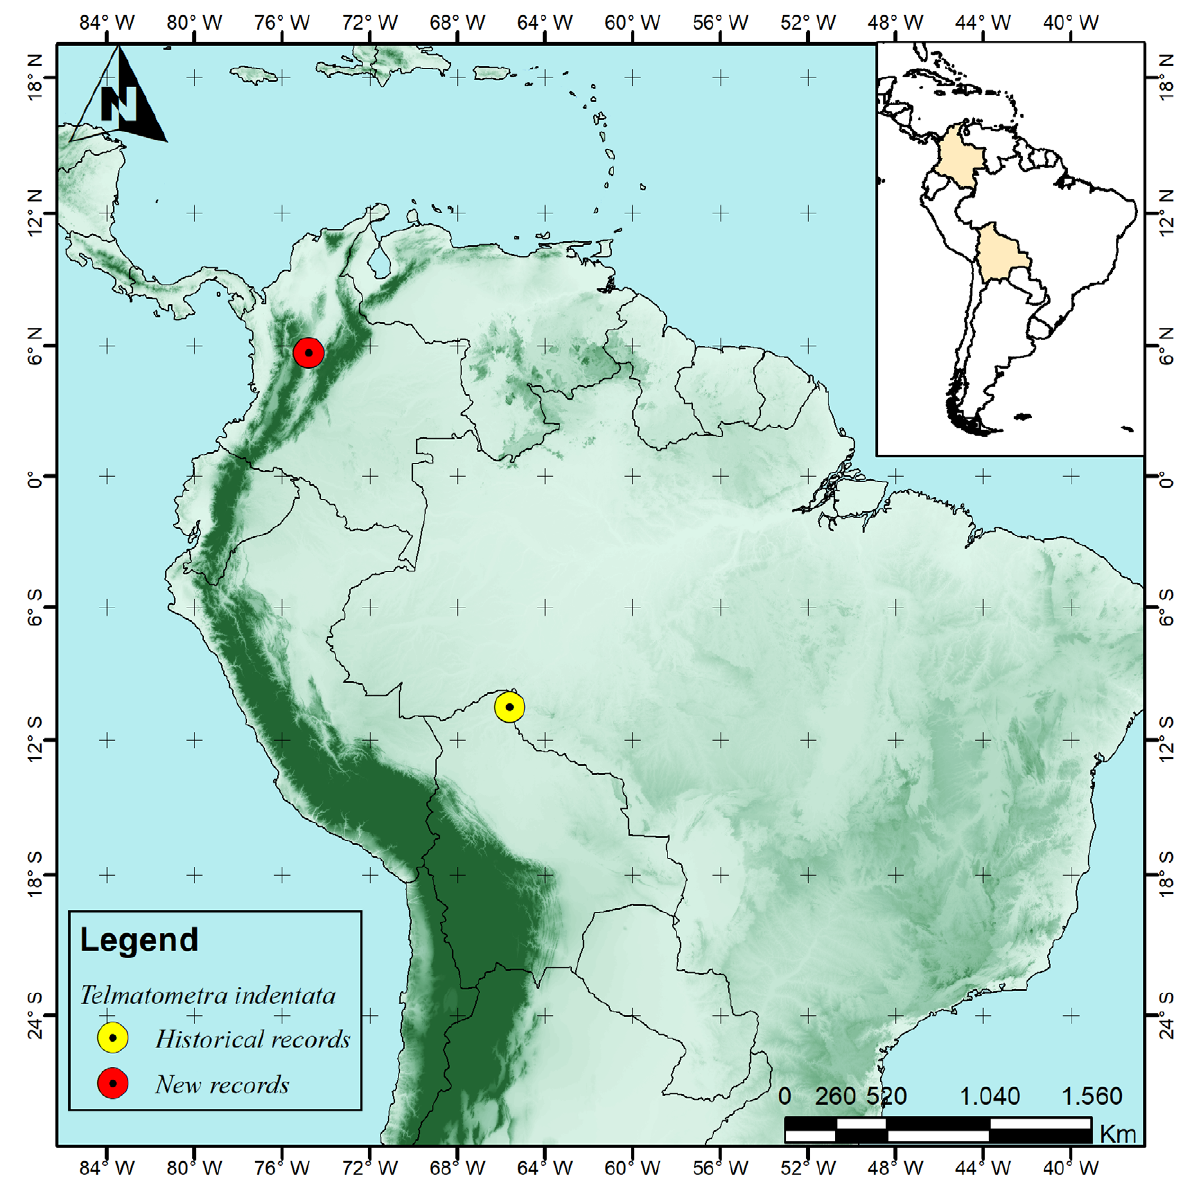
Figure 9. Historical and new records of Telmatometra indentata in the